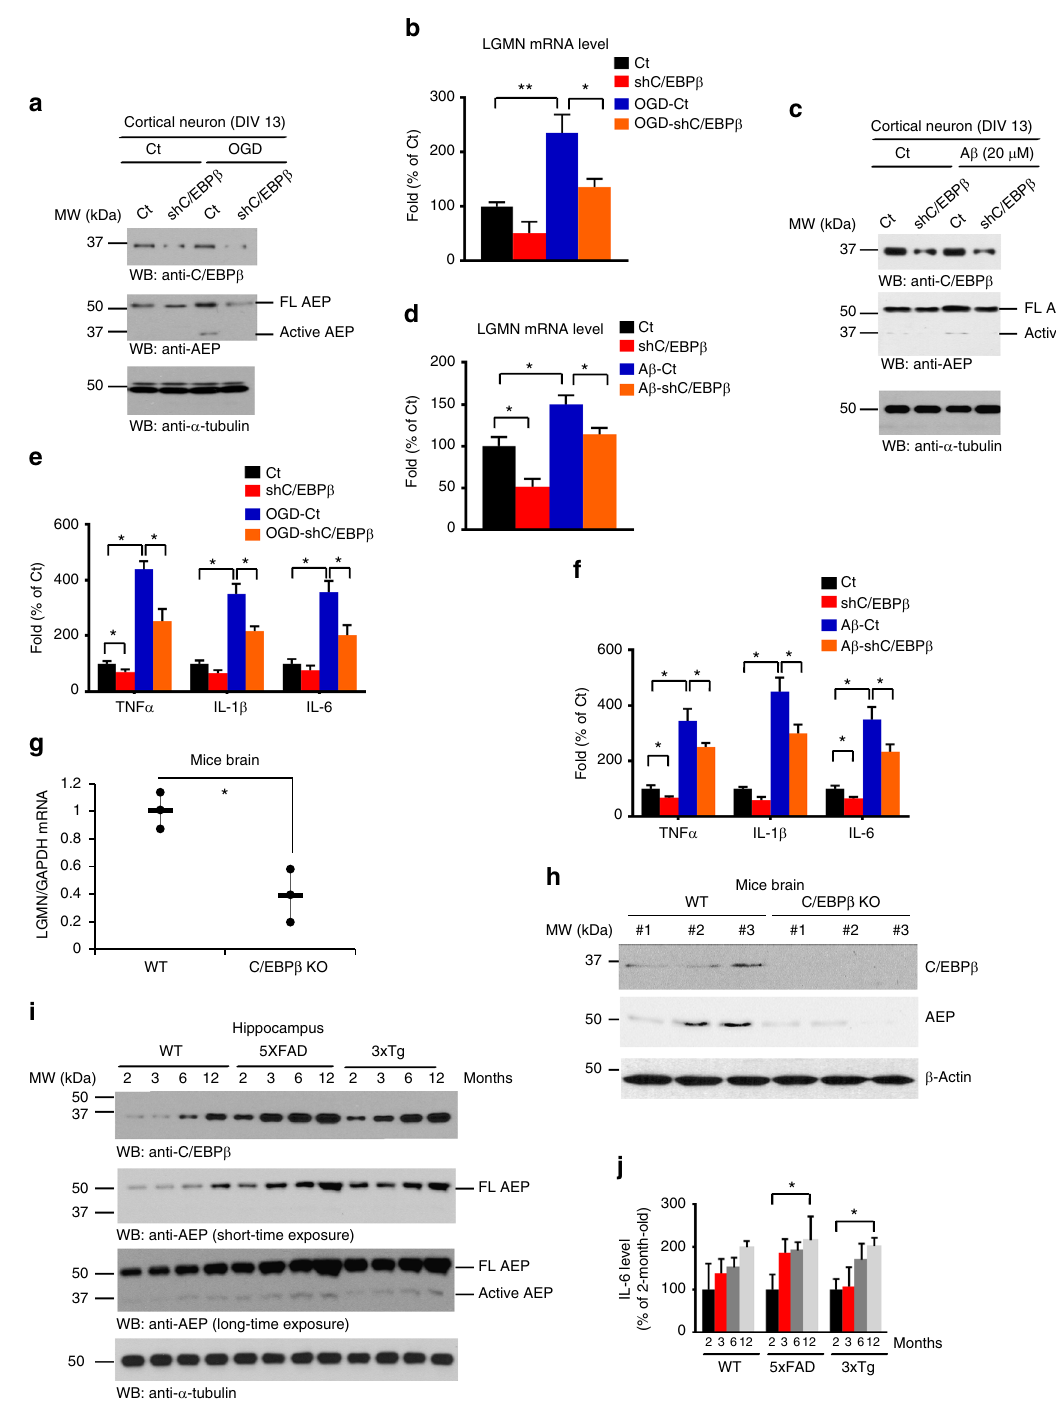
Fig. 4 Depletion of C/EBP β diminishes OGD or A β -induced delta-secretase expression. a , b Knockdown of C/EBP β reduces delta-secretase expression induced by OGD. Immunoblotting and real-time PCR were conducted from primary cultures infected with virus expressing control or shRNA against C/ EBP β . c , d Knockdown of C/EBP β reduces delta-secretase expression induced by A β . Western blot data in a , b are representative of three independent experiments. Data in c , d represent mean ± s.e.m. of three independent experiments (* P < 0.05, ** P < 0.01, one-way ANOVA). e , f OGD and A β stimulate in fl ammatory cytokine expression, and knockdown of C/EBP β reduces cytokine levels. Data represent mean ± s.e.m. of three independent experiments (*P < 0.05, one-way ANOVA). g , h Knockout of C/EBP β signi fi cantly reduces delta-secretase expression in the brain. Wild-type or C/EBP β KO mice (4 – 5 months old) were sacri fi ced and their brains were isolated. Delta-secretase ’ s mRNA ( g ) and protein ( h ) levels in the brains were analyzed by western blotting and real-time PCR. C/EBP β knockout was con fi rmed by immunoblotting. Data in g represent mean ± s.d. of three mice per group; * P < 0.05, Student ’ s t -test. i Immunoblotting analysis of delta-secretase and C/EBP β in age-matched wild-type, 5XFAD and 3xTg AD mice. Wild-type and AD mice of different ages were sacri fi ced and their brain lysates were subjected to western blotting analysis. j IL-6 is escalated in AD mouse models in an age- dependent manner. Wild-type and AD mice of different ages were sacri fi ced and their brain lysates were subjected to IL-6 ELISA analysis. Data represent mean ± s.e.m. of three independent experiments (* P < 0.05, one-way